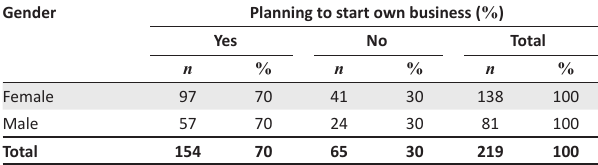
TABLE 7: Respondents who are jobseekers within the community work programme by gender. Gender Seeking for a job ( % )